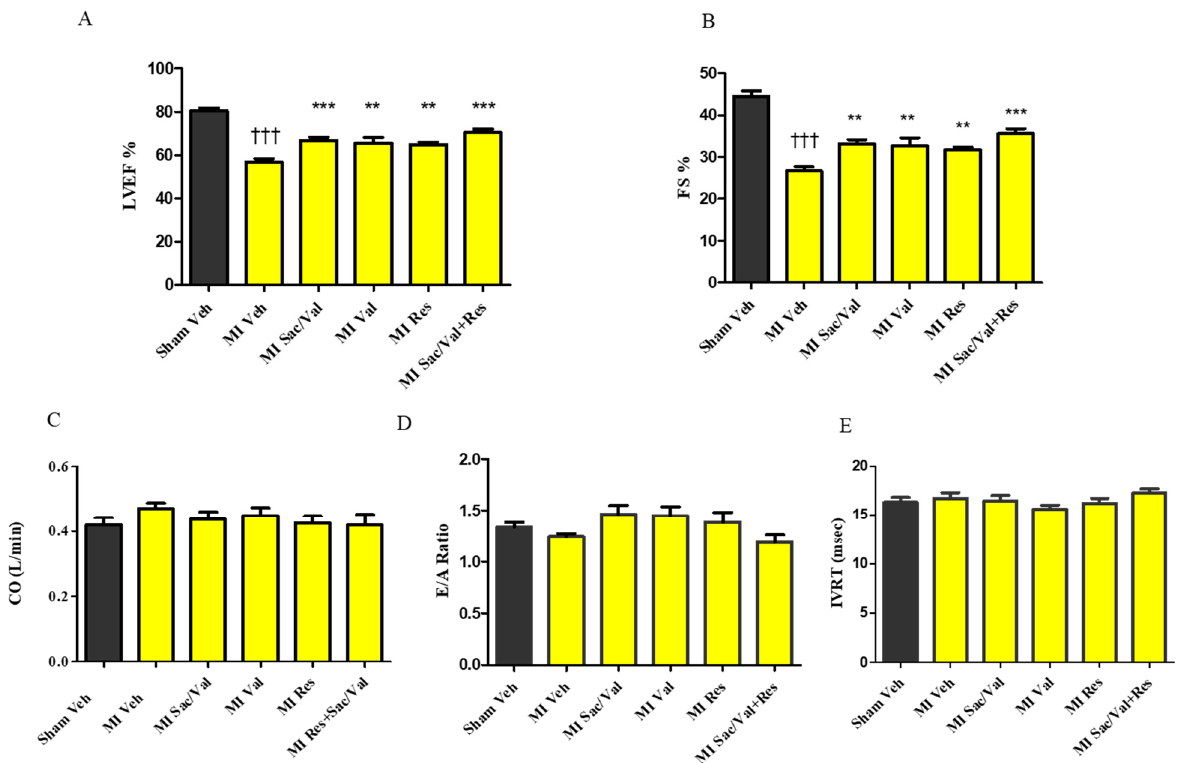
Figure 3. ( A ) Left ventricular ejection fraction (LVEF); ( B ) Fractional shortening (FS); ( C ) Cardiac output (CO); ( D ) E/A ratio; ( E ) Isovolumic relaxation time (IVRT) of sham and MI rats. All values are expressed as mean ± SEM, n = 9–11. ††† p < 0.001 vs. Sham Veh; ** p < 0.01, *** p < 0.001 vs. MI Veh. Veh—vehicle, Sac/Val—sacubitril/valsartan, Res—resveratrol, Val—valsartan.